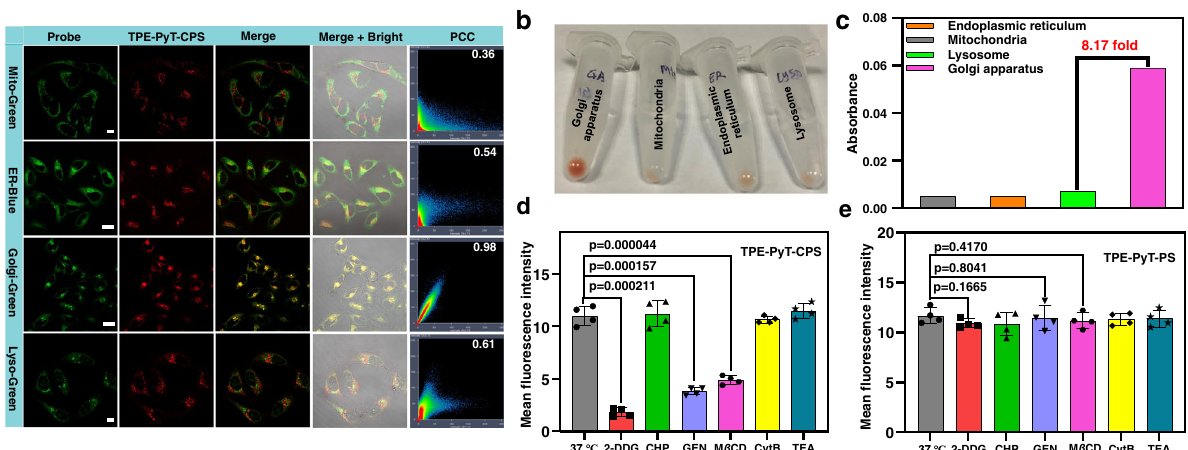
Fig. 4 Subcellular co-localization of TPE-PyT-CPS and the uptake behavior difference between TPE-PyT-PS and TPE-PyT-CPS. a CLSM of HeLa cells stained with different commercial probes (Mito-Green: 495-535nm, λ ex , 488 nm. ER-Blue: 455-520nm, λ ex , 405 nm. Golgi-Green: 495-535nm, λ ex , 488 nm. Lyso-Green: 495-535nm, λ ex , 488 nm) and TPE-PyT-CPS (10 μ M, 600-750nm, λ ex , 488 nm). Scale bar: 20 μ m for ER and Golgi channel;10 μ m for Mito and Lyso channel. b Distribution images and UV absorption of TPE-PyT-CPS (c) in each organelle after separation by subcellular organelle kits. Average fl uorescence intensity of HeLa cells after incubated with TPE-PyT-CPS ( d ) and TPE-PyT-PS ( e ) in the presence of different endocytosis inhibitors including 2-DDG, CHP, GEN, M β CD, CytB and TEA. Experiments in 4a were performed three times independently and experiments in 4b-c were performed two times independently, representative images are shown. Data in d and e are presented as mean ± SD derived from n = 4 biologically independent experiments. Statistically signi fi cant differences between the experimental groups were analyzed by two-tailed Student ’ s t-test. when p < 0.05, it was considered to have statistical signi fi cance. Source data are provided as a Source Data fi